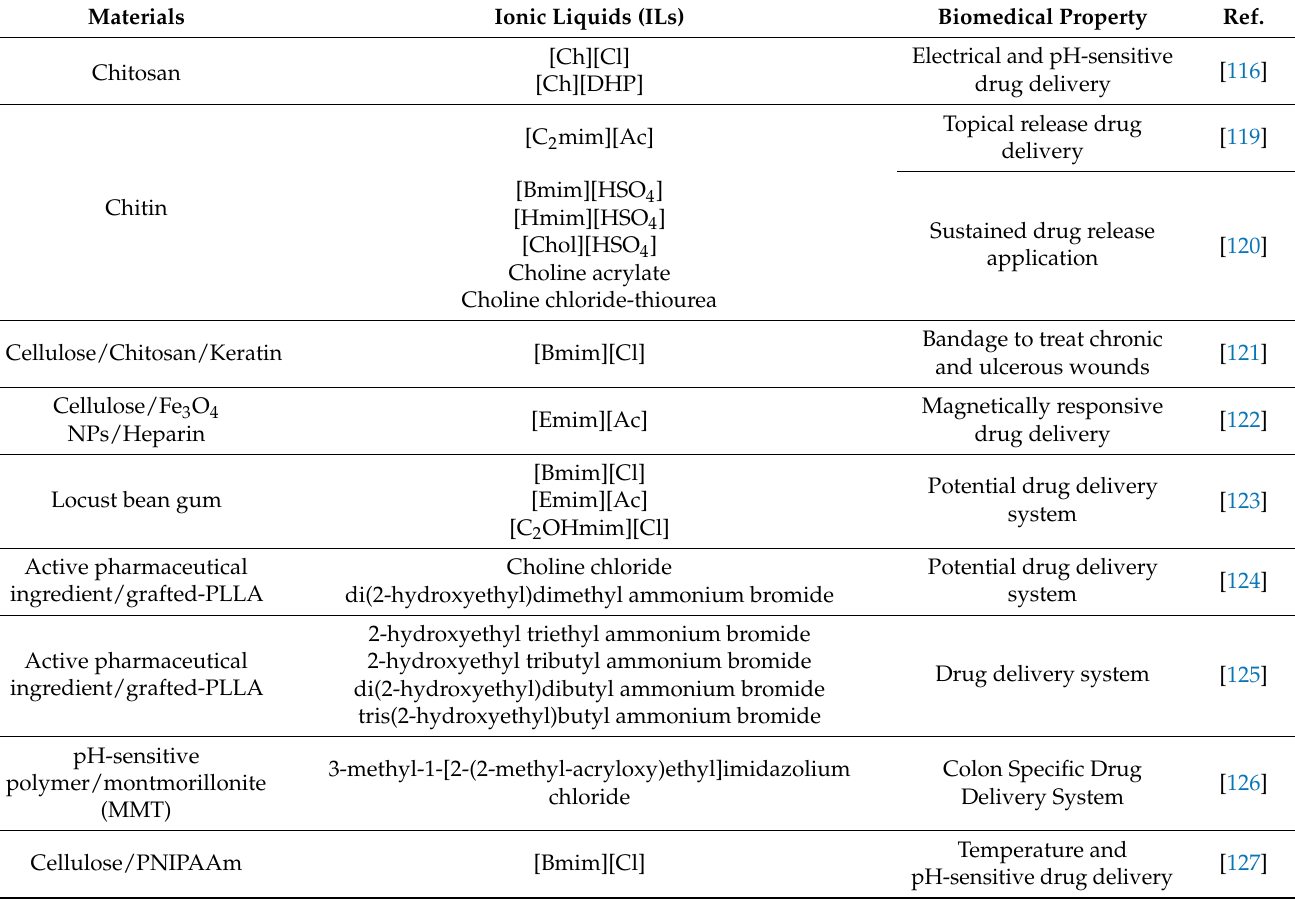
Table 1. IL-based hybrid materials for drug delivery